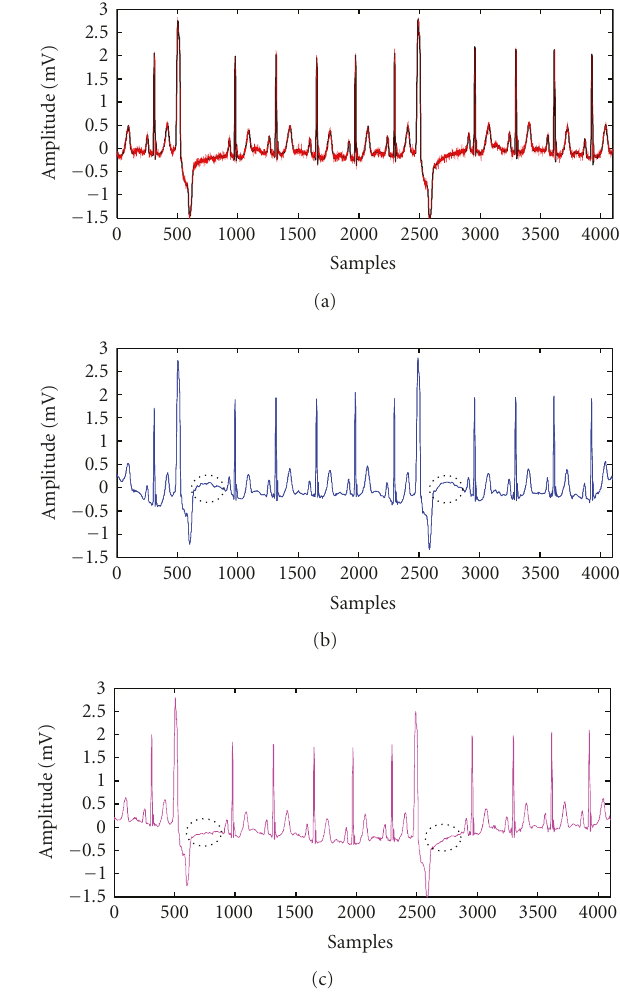
Figure 7: Denoising results of HBWT applied to an ECG (MIT-BIH record 119) with ectopic beats. (a) Clean and noisy ECG, (b) HBWT with 3 levels of adaptation, (c) HBWT with the adaptation applied to all decomposition levels. The surrounding circles indicate the ST segment of the ectopic